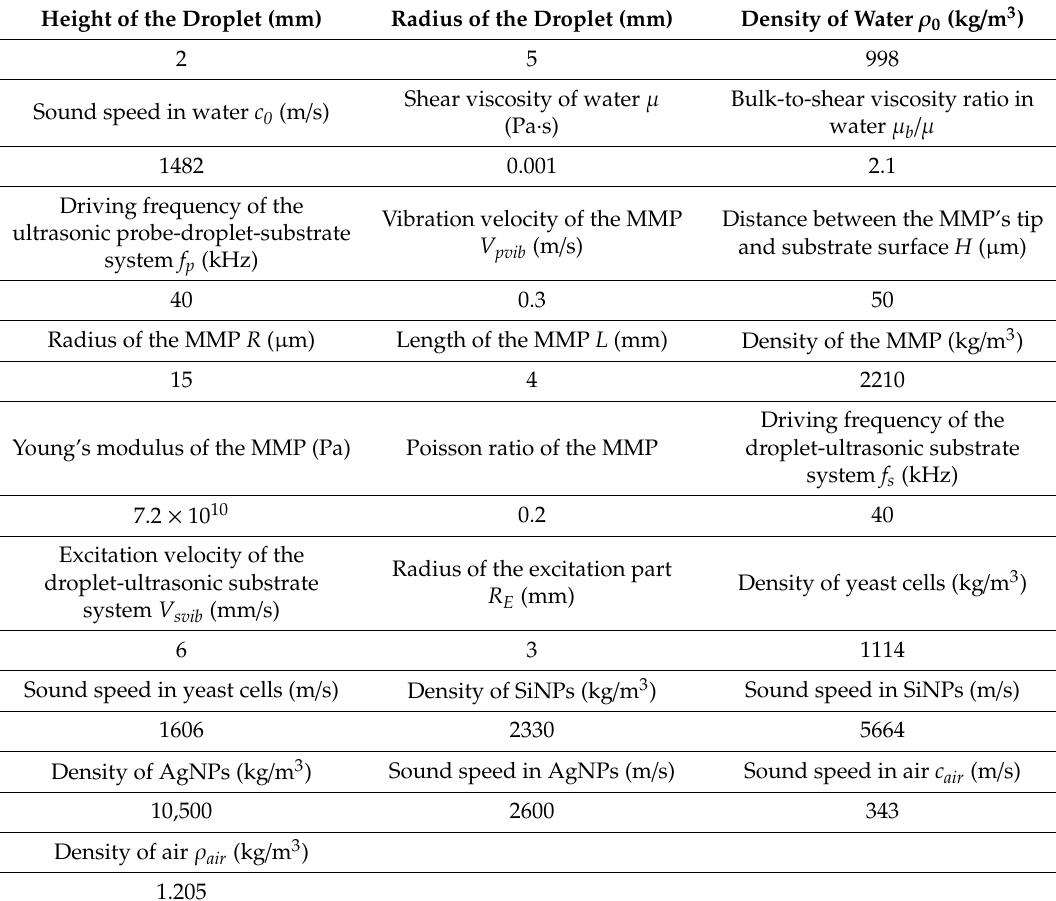
Table 1. Structural sizes, material parameters and working conditions of the manipulation systems used in the